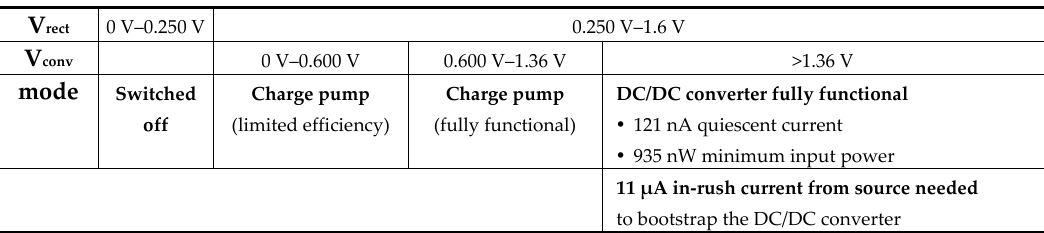
Table 1. DC/DC converter functional modes.